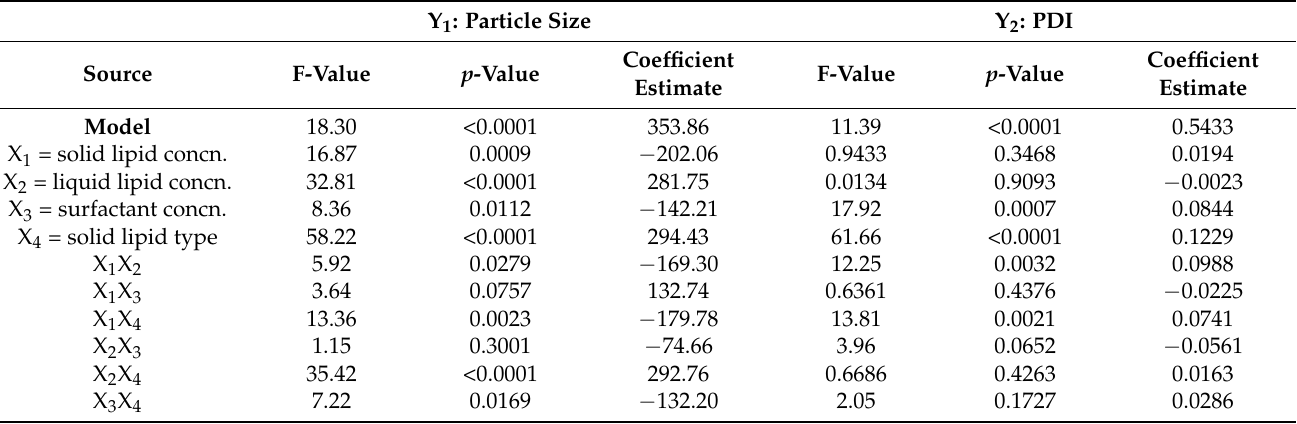
Table 2. Analysis of variance (ANOVA) for 2FI (two factors interaction) model. Term X1 corresponds to the solid lipid concentration, X2 to the liquid lipid concentration, X3 to the surfactant concentration, and X4 to the solid lipid